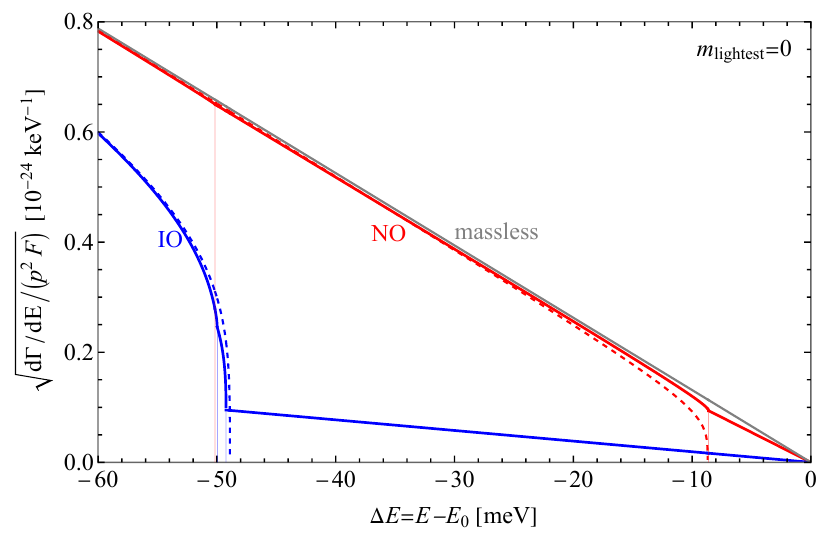
Figure 2 . Kurie plot of the tritium energy distribution as measured from the zero-mass endpoint for a massless lightest neutrino with NO (red) and IO (blue) of the three active neutrinos. The red (blue) dashed lines correspond to the effective m β approximation for NO (IO) as given by eq. (1.3). The gray line corresponds to the single massless active neutrino